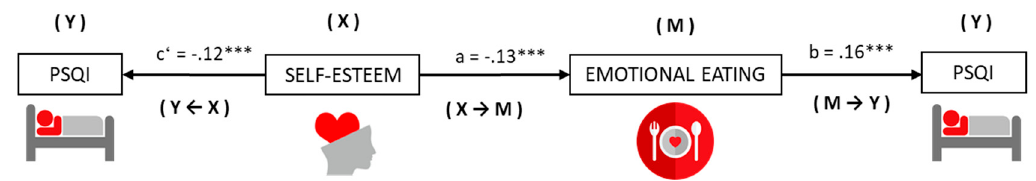
Figure 1. Mediation model of emotional intake in the relationship between self-esteem and sleep quality.